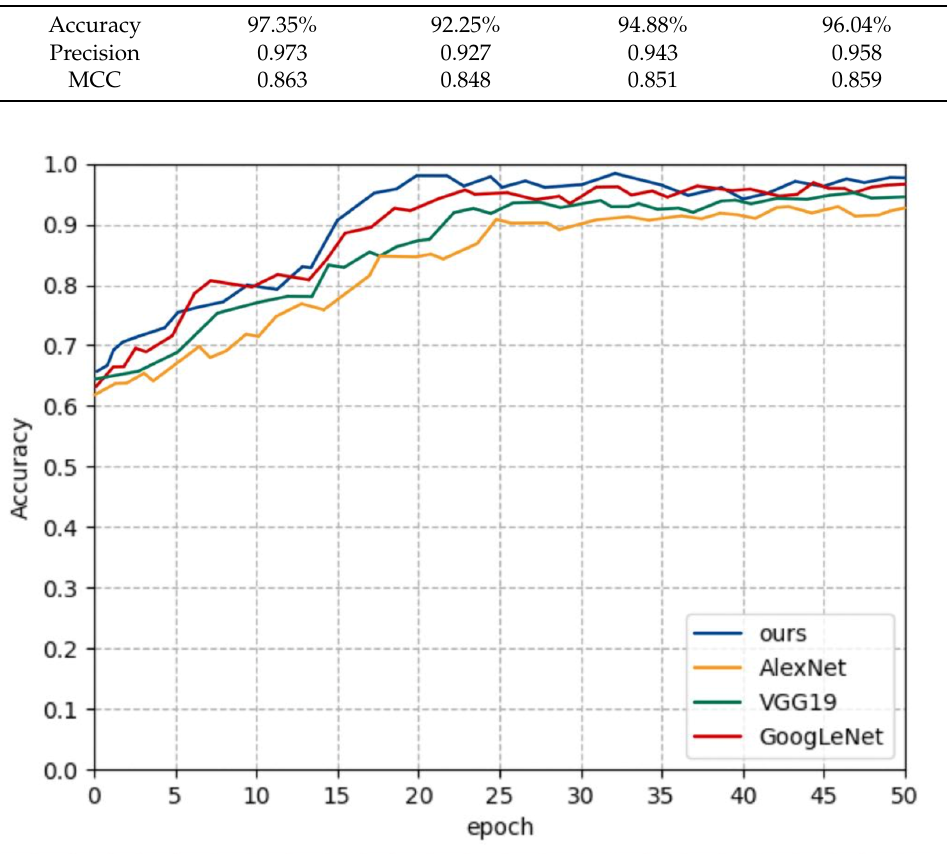
Figure 11. Training process of CNN models.